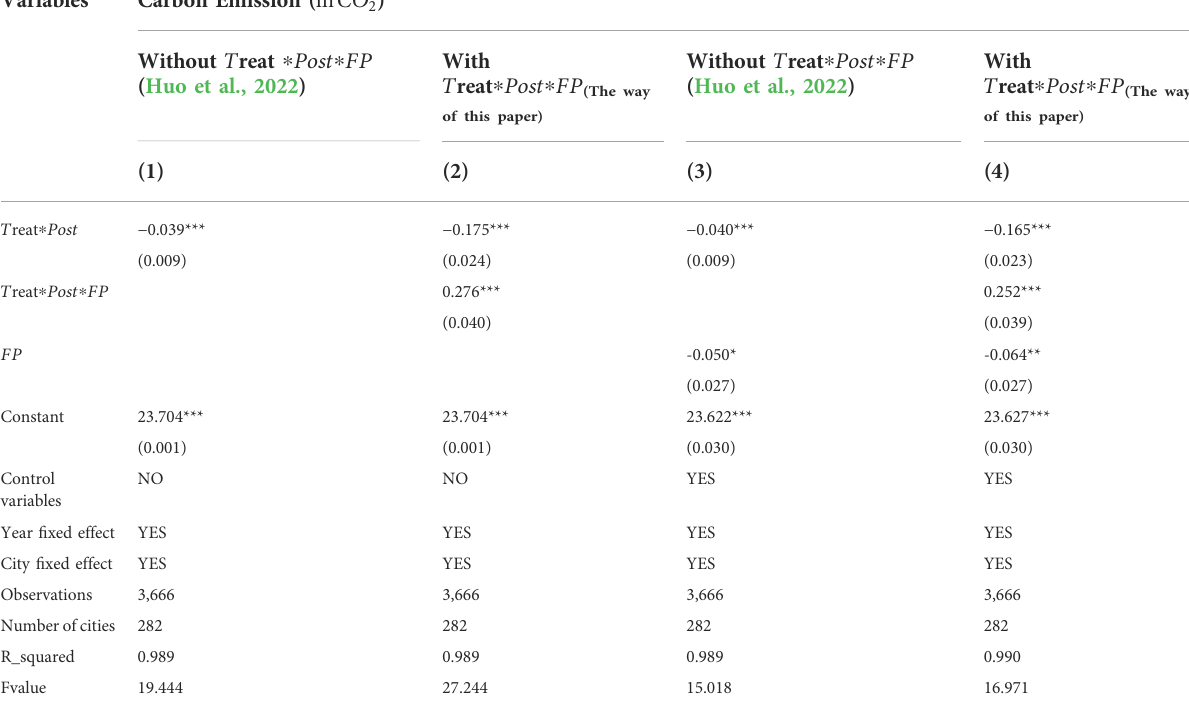
TABLE 4 Estimations after using lnCO 2